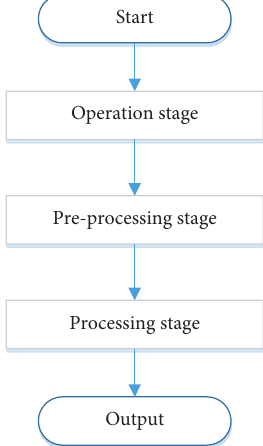
Figure 2: A framework of the